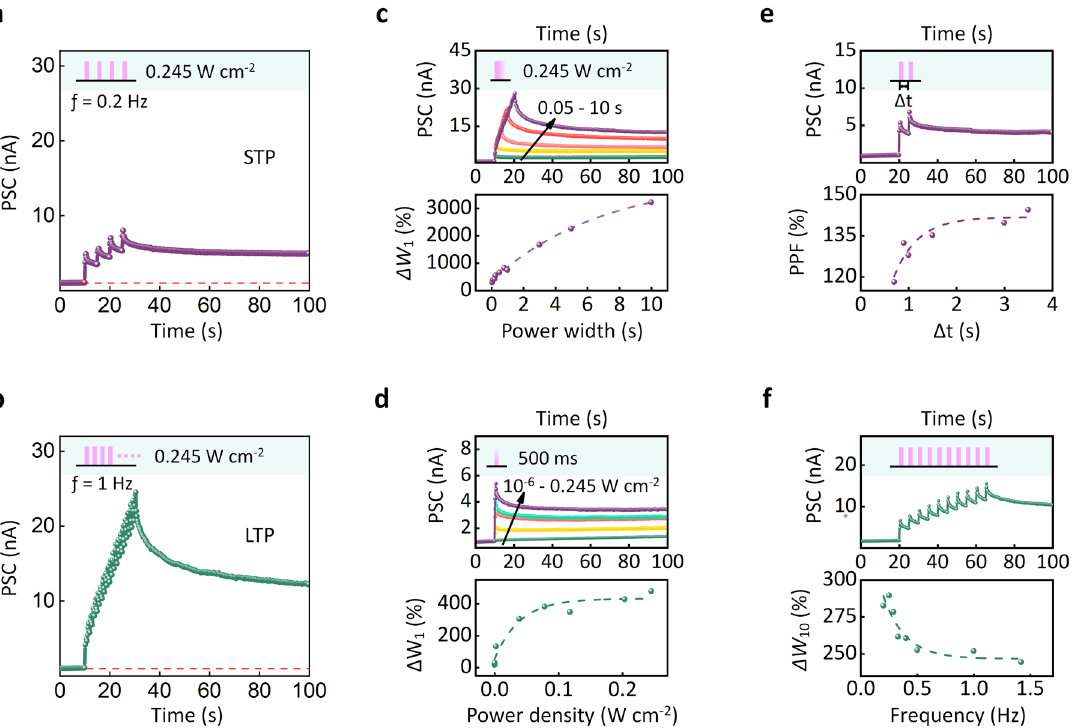
Fig. 3 Synaptic plasticity of the InSe-based device. a Short-term plasticity (STP) and b long-term plasticity (LTP) behavior of the InSe optoelectronic synapse illuminated by a 405-nm laser with a pulse width of 500 ms, a power density of 0.245 W cm − 2 , and frequency of 0.2 Hz (STP) and 1 Hz (LTP). The amplitudes and weight variations ( Δ W 1 ) of the postsynaptic current (PSC) under different c presynaptic pulse widths increasing from 0.05 to 10 s and d illumination intensity ranging from 10 − 6 to 0.245 W cm − 2 . e Paired-pulse facilitation (PPF) emulated by two identical presynaptic spikes (power intensity of 0.245 W cm − 2 , exposure duration of 500 ms) and PPF ratio as a function of pulse interval ( Δ t ). f PSC response triggered by a series of ten presynaptic spikes and the weight change of PSC ( Δ W 10 ) as a function of frequency. Note that all results were done at V bg = − 40 V and V ds = 0.5